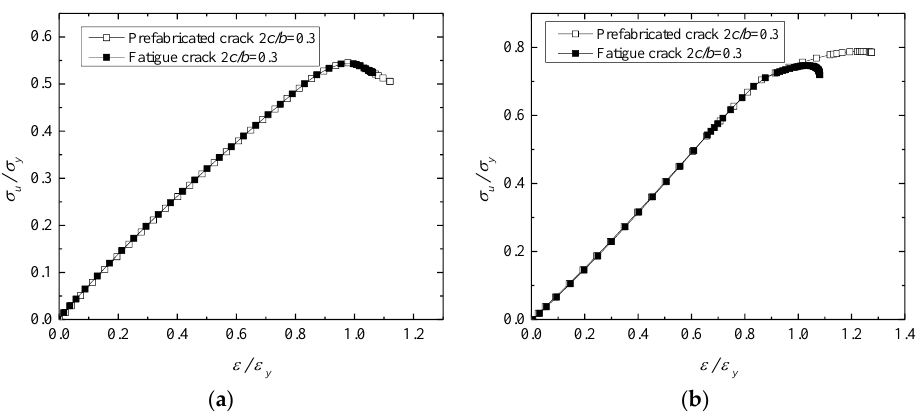
( b ) Figure 14. Out-of-plane deformation distribution of cracked plate at minimum load: ( a ) 𝑃 = 0.7𝜎 𝑢 , ∆𝑐 = 90 mm ; ( b ) 𝑃 = 0.9𝜎 𝑢 , ∆𝑐 = 90 mm . 3.5. Effect of Crack type To investigate the effect of crack type on the residual strength of cracked plate, the